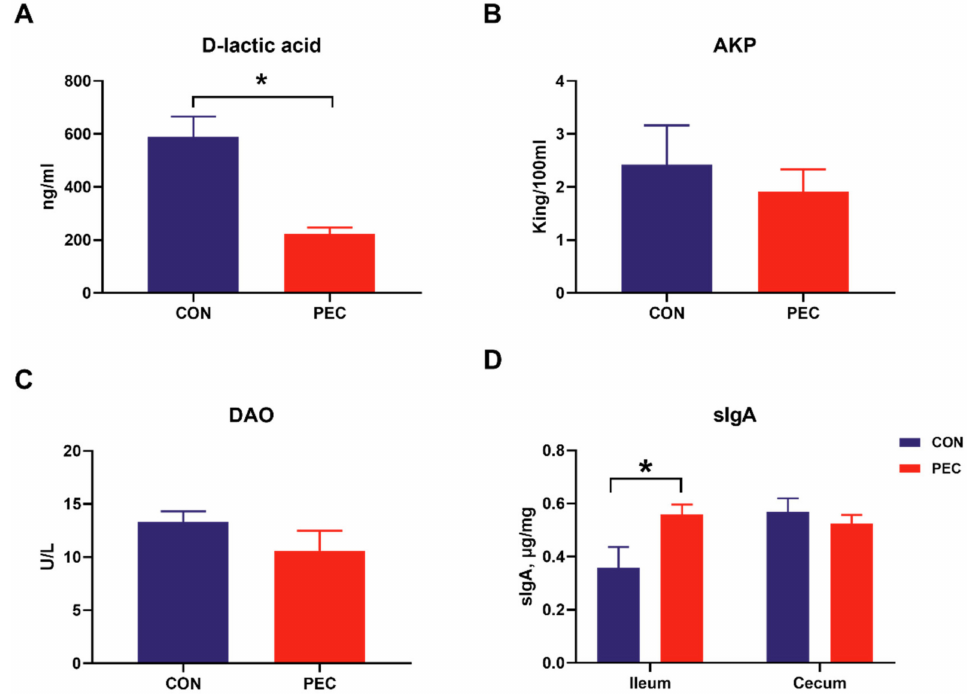
Figure 1. The concentration of D-lactic acid ( A ), AKP ( B ) and DAO ( C ) in serum and sIgA content ( D ) in intestinal mucosa of pigs fed either the control or pectin diet. Values are means (n 6 / diet), with their standard errors represented by vertical bars. * Means statistically significant ( p ≤ 0 ·